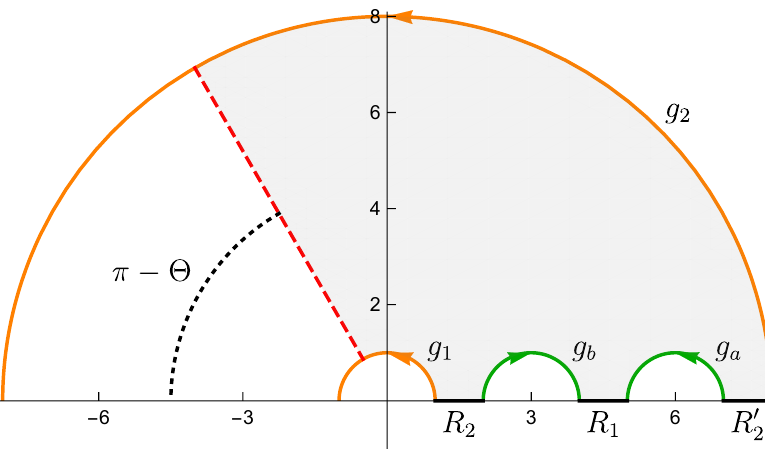
Figure 12 . A covering space (upper half plane H 2 ) depiction of the inception geometry with . Note that this does not include the D 2 = 8 ; D 1 = 1 ; X a = 6 ; D a = 1 ; X b = 3 ; D b = 1 ; (cid:2) = 2 (cid:25) 3 \real" black hole region, which appears as a thermo(cid:12)eld double with one asymptotic region cut o(cid:11) by the brane, as in the top left panel of (cid:12)gure 11. The shaded gray region is a fundamental region. The orange (resp. green) semicircles are identi(cid:12)ed with the orientations shown. The dashed red segment is the brane location as seen from the inception region; if extended, it would intersect the origin. The circles are labeled according to their parametric equations (3.5){(3.8). The radiation is split into two disjoint subregions, R 1 and R 2 ( R 2 and R 0 join to form a single asymptotic region 2 after the identi(cid:12)cations). These radiation regions are asymptotic regions (black segments) in the multiboundary wormhole geometry, where the gray shading approaches the boundary (horizontal axis). The angle (dotted black arc) formed by the negative horizontal axis and the brane is (cid:25) (cid:0) (cid:2). Notice that the brane location cuts o(cid:11) what would have become a third asymptotic region in the standard multiboundary wormhole geometry (cid:6) 3